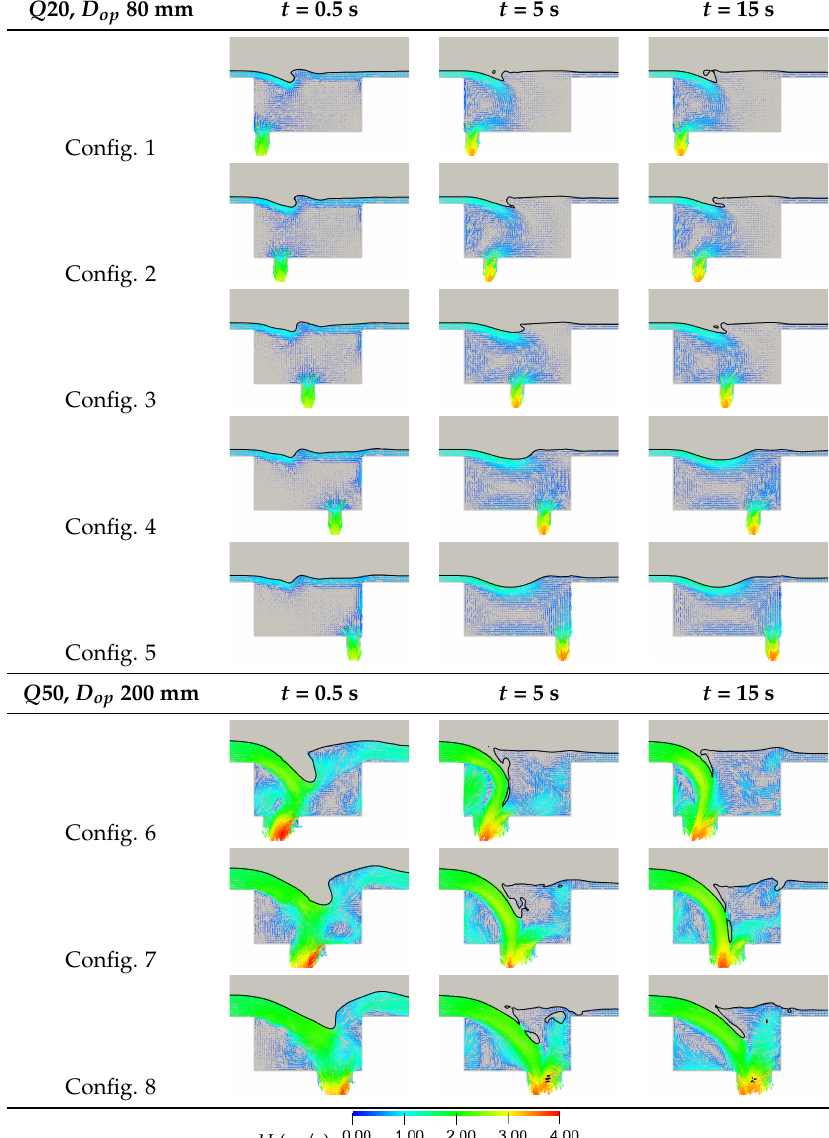
Table 4. Flow through the gully in its central plane—Config. 1 to 5, D op = 80 mm for Q20 and Configurations 6 to 8, D op = 200 mm for